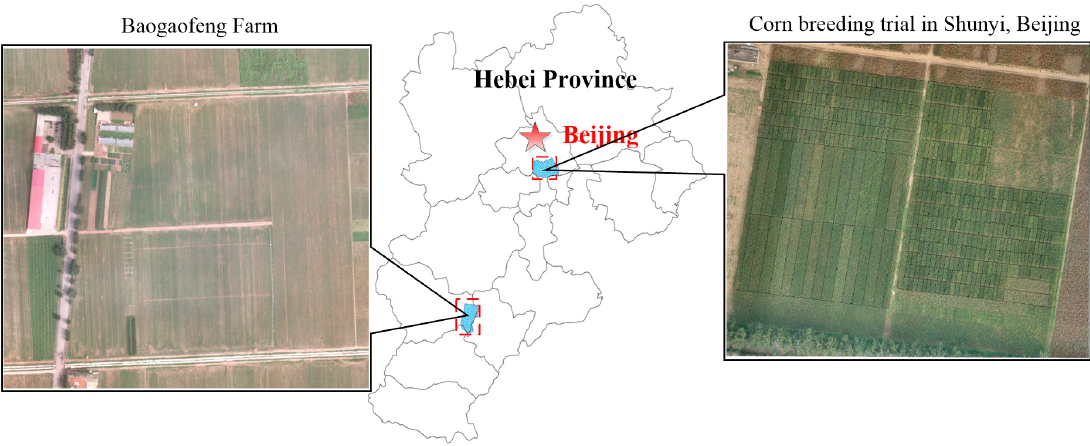
Figure 1. Locations of the two study areas. The Baogaofeng Farm study was performed in Mazhuang Town, Xinji City, Hebei Province (left), and the Shunyi corn breeding trial was performed in Shunyi District, Beijing, China (right).